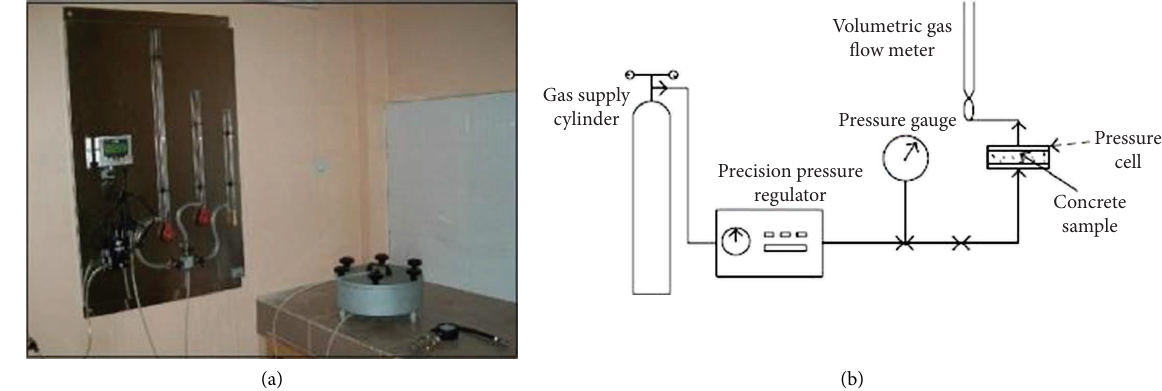
0.20.40.60.811.21.4 0